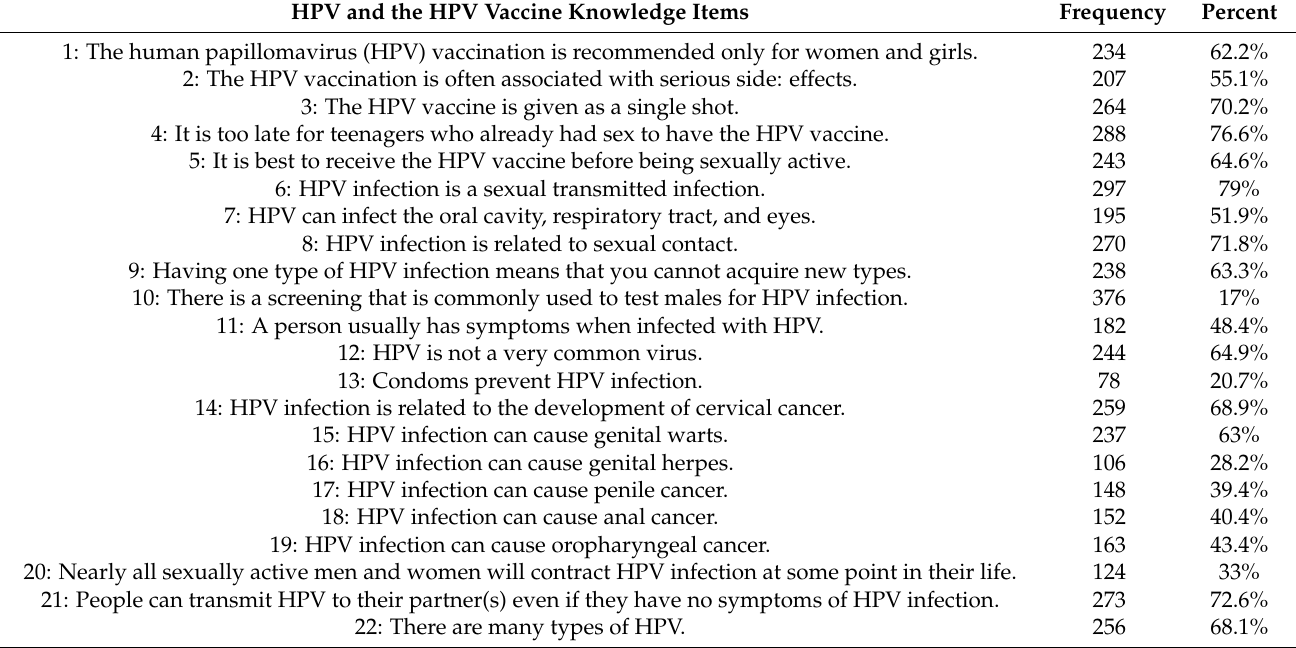
Table 4. Number of foreign-born college students respondents answering questions about HPV and the HPV vaccine